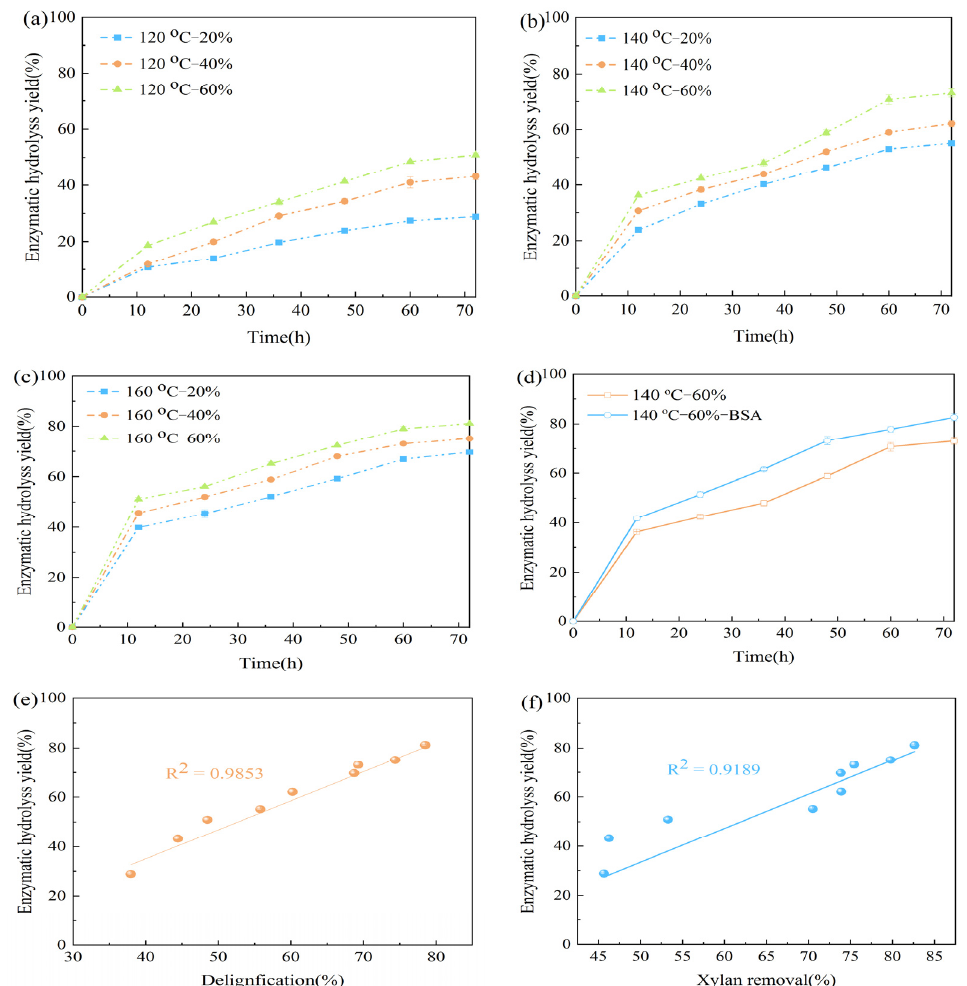
Figure 3. Enzymatic hydrolysis yield of pretreated VR at 120 °C ( a ), 140 °C ( b ), and 160 °C ( c ). Enzymatic digestibility of pretreated VR (140 °C, 60% phenoxyethanol) with or without BSA ( d ). Correlations between xylan removal yield ( e ) and degree of delignification ( f ) and enzymatic digestibility of pretreated VR.